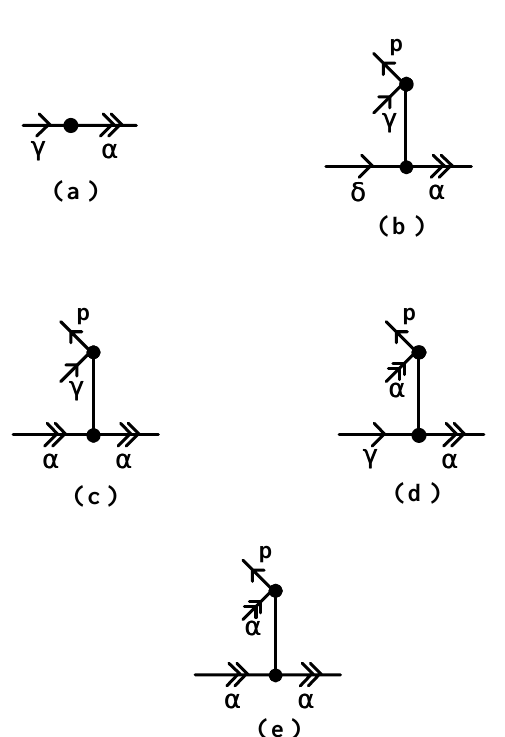
Figure 1: The various types of S operators for the one-hole model space Φ α . (a) and (b) are S e operators, and the rest are S r